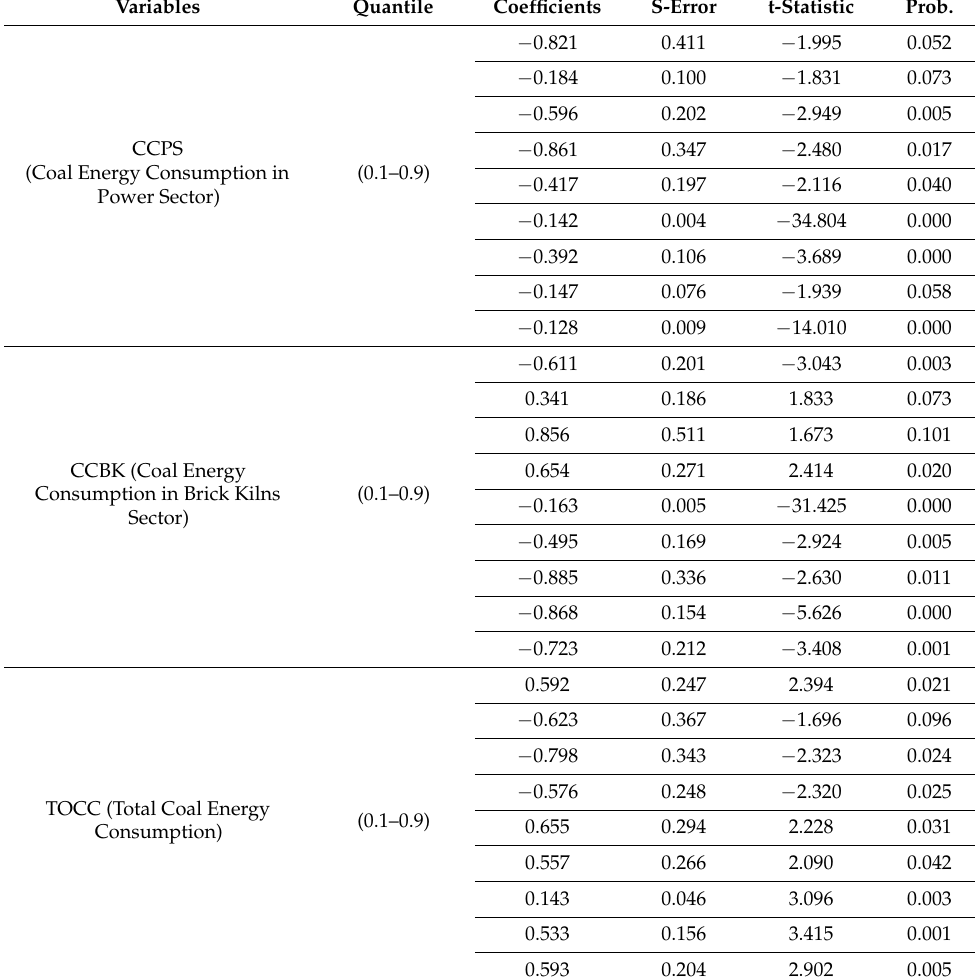
Table 5. Consequences of estimated quantile